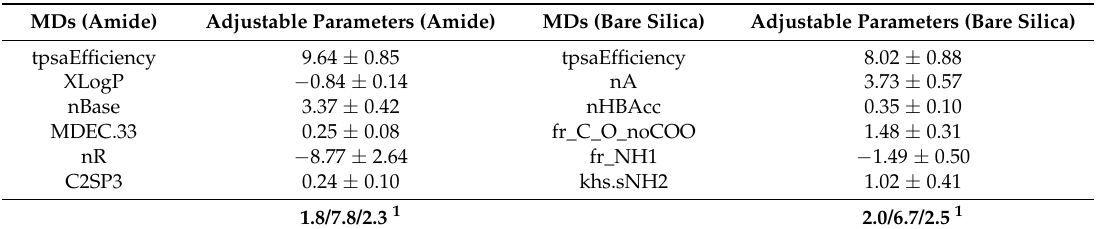
Table 1. QSRR models describing the retention of 94 metabolite standards for each chromatographic based on Equation (2).